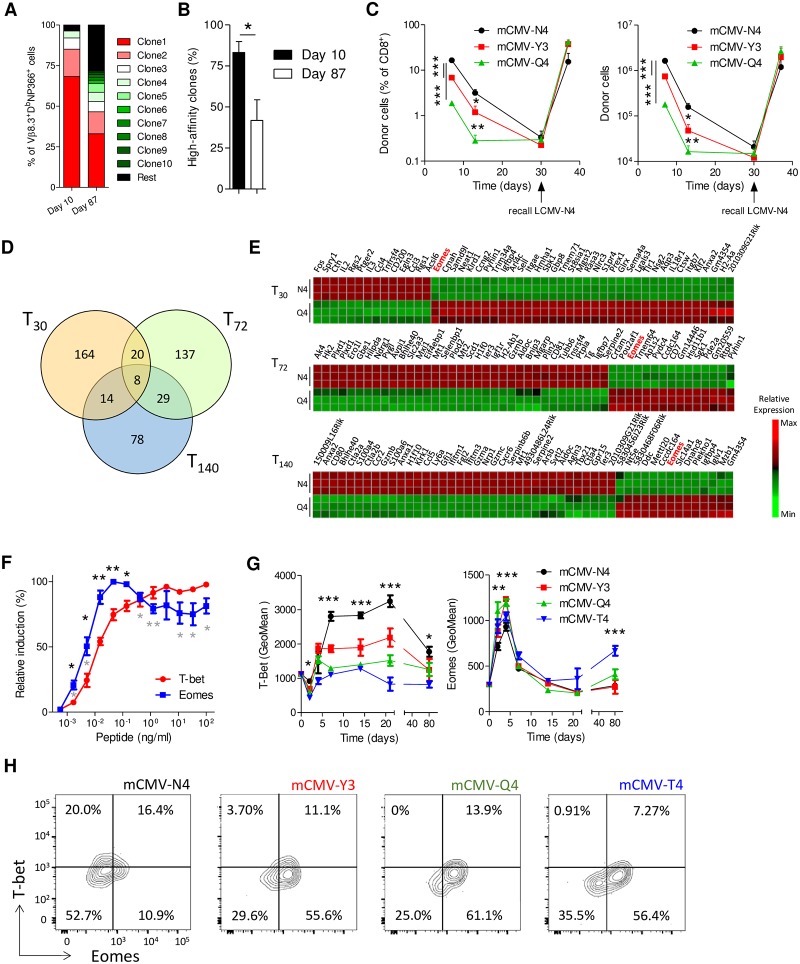
Submaximal TCR stimulation corresponds with higher expression of Eomes.(A-B) Mice were infected with influenza A strain PR/8/34. Ten (effector) and 87 (memory) days after infection, CD8+DbNP366+ cells were sorted, and their TCR was analyzed by NGS within the dominant Vβ8.3 family. (A) Frequency of clones as a percentage of total reads is given. Clones are ranked by relative size. Shown is the average clonal diversity from three mice per time point. (B) Cumulative contribution of the public high-affinity clones SGGS, SGGA, and SGGG (n = 3 per time point) to the total CD8+DbNP366+Vβ8.3+ repertoire. (C) CD45.1+ OT-1 cells (104) were transferred to WT CD45.2+ recipients. After 24 hours, mice were infected with mCMV expressing the indicated peptides. Thirty days after infection, mice were reinfected with LCMV-N4. Shown is (left) the frequency and (right) absolute numbers of donor cells in spleen, determined by flow cytometry. (D,E) Purified OT-1 cells were primed for 30 hours with 1 ng/ml N4 or Q4 peptides and anti-CD28. Next, cells were washed and cultured for an additional 5 days with 50 ng/ml IL-15 to generate memory cells. RNA was isolated after 0, 30, 72, and 140 hours of culture (n = 3). (D) Venn diagram of differentially expressed genes between N4- and Q4-stimulated cells at indicated time points. (E) Heat map of top-50 differentially expressed genes at indicated time points. See also S1 Table. (F) Purified OT-1 cells were stimulated in vitro with anti-CD28 and indicated concentrations of N4 peptides. After 30 hours, relative induction of protein expression of T-bet and Eomes was determined by flow cytometry. Black asterisks indicate significant differences between T-bet and Eomes. Gray asterisks indicate significant differences of Eomes expression with cells stimulated at maximum signal (0.05 ng/ml). (G,H) CD45.1+ OT-1 cells were transferred in WT (CD45.2+) recipients. After 24 hours, mice were infected with mCMV expressing the indicated peptides. (G) Expression of T-bet and Eomes in donor cells in spleen was followed over time by flow cytometry. (H) Representative FACS plots show cells on day 2 after infection, with mCMV expressing the indicated peptides. Gated was for CD8+CD45.1+ cells. (D,E) Data from microarray analysis of three biologically independent samples, each pooled from 3–4 mice. Experiments show representative data from at least two (A-C) or four (F-H) independent experiments using 3–5 mice per group. In (C,G), ANOVA followed by Bonferroni posttesting was used; in (B,F), Student t test was used to analyze difference between groups. Shown are means ± s.e.m. *P < 0.05, **P < 0.01, ***P < 0.001. Values for each data point can be found in S1 Data. FACS, fluorescence-activated cell sorting; GeoMean, geometric mean; IL, interleukin; LCMV, lymphocytic choriomeningitis virus; mCMV, murine cytomegalovirus; N4, SIINFEKL; NGS, next-generation sequencing; Q4, SIIQFEKL; T4, SIITFEKL; TCR, T-cell receptor; WT, wild-type Y3, SIYNFEKL.